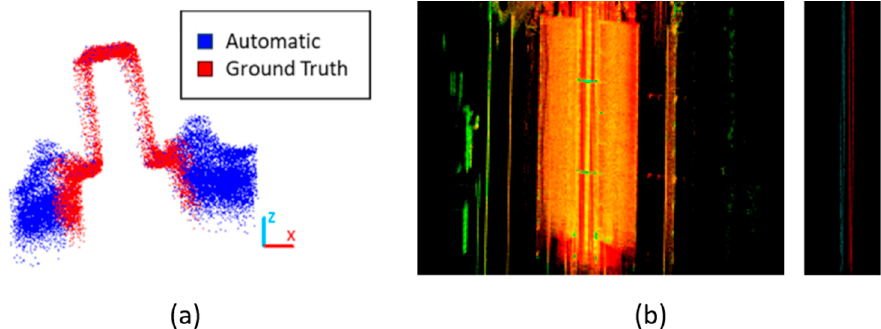
Figure 9. Rails. ( a ) Sánchez–Rodríguez et al. [59] classified them analysing the point cloud curvature (elevation difference) and validated the results applying SVM classifiers. ( b ) Lou et al. [137] detected rails based on their elevation difference together with their reflection characteristics. The figure is coloured by intensity.